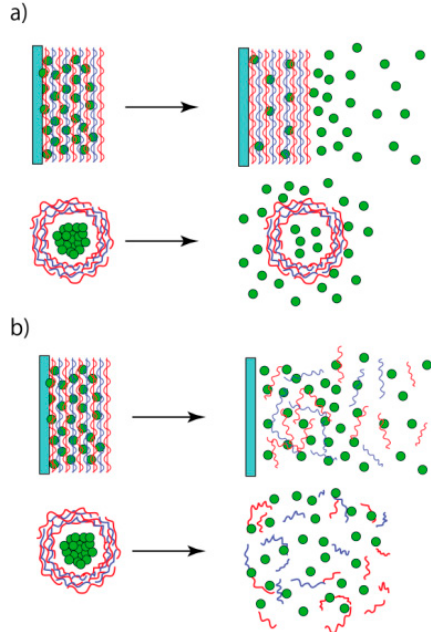
Figure 8. Release of drugs and proteins from LbL films and microcapsules through permeability changes ( a ) and decomposition ( b ). Reprinted from Ref. [82]. Copyright 2017